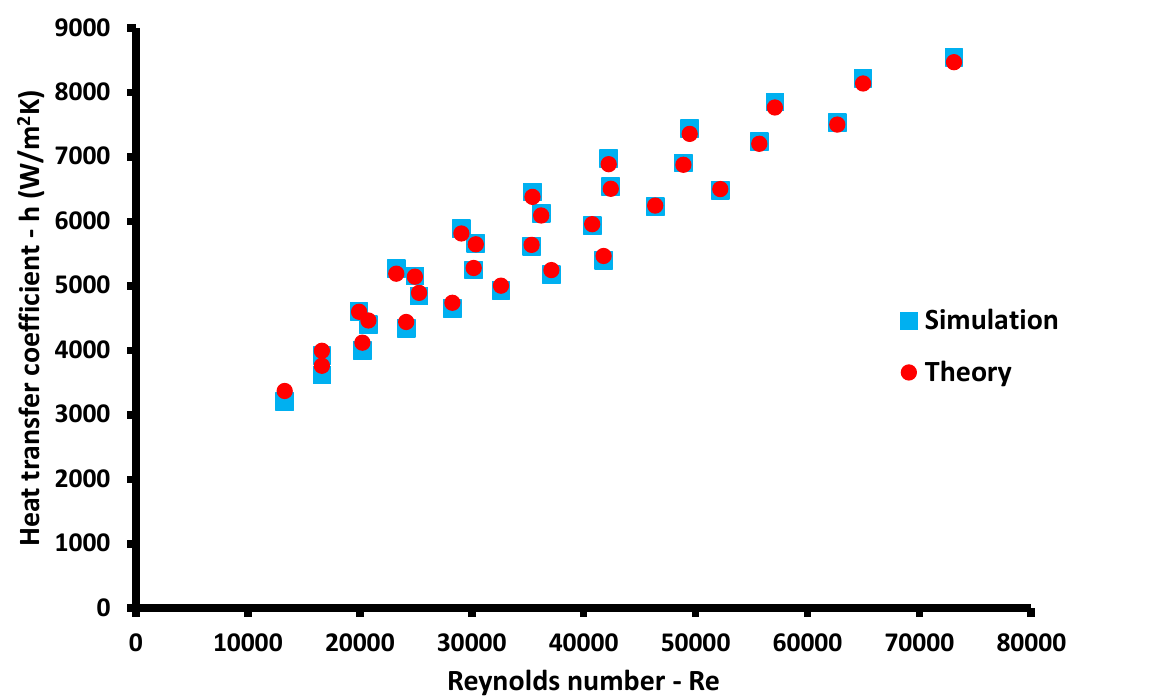
Figure 3. Heat transfer coefficient from simulation studies and theoretical calculations.